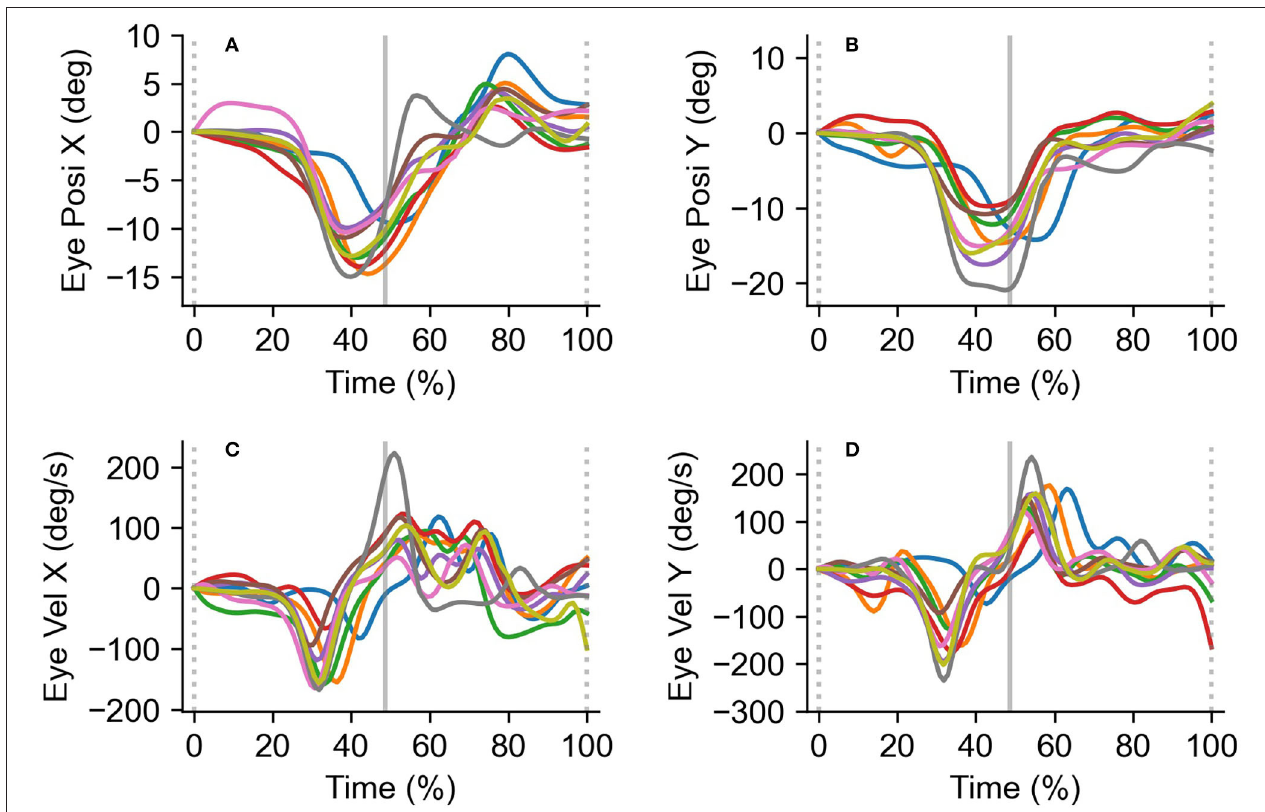
FIGURE 4 | Typical eye position (top) and velocity (bottom) traces. Eye position in the horizontal (A) and vertical (B) directions, and eye velocity in the horizontal (C) and vertical (D) directions are shown. All traces were obtained from a single trial (10 rallies a trial). The definition of the vertical lines is the same as in Figure 3 . Upward deflections indicate upward or leftward